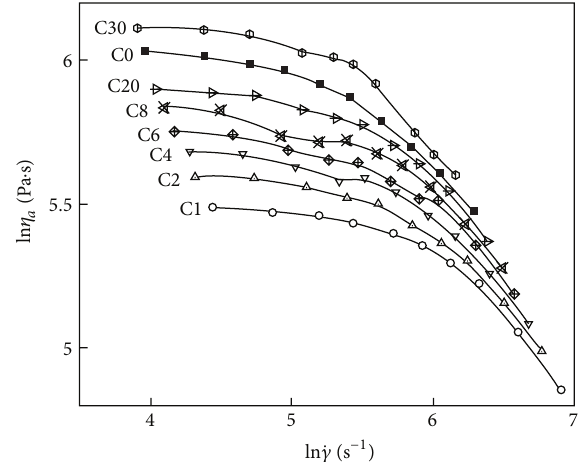
Figure 2: Relationship between the apparent viscosity and shearing rate of the various PTT/CaCO 3